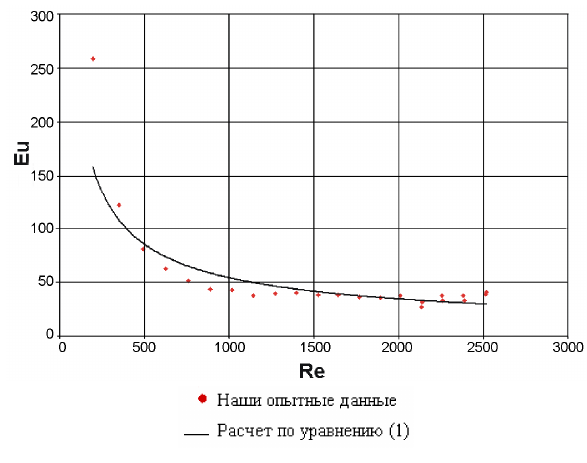
Рис. 10. График зависимости Eu = f (Re) для насадки типа N3C.